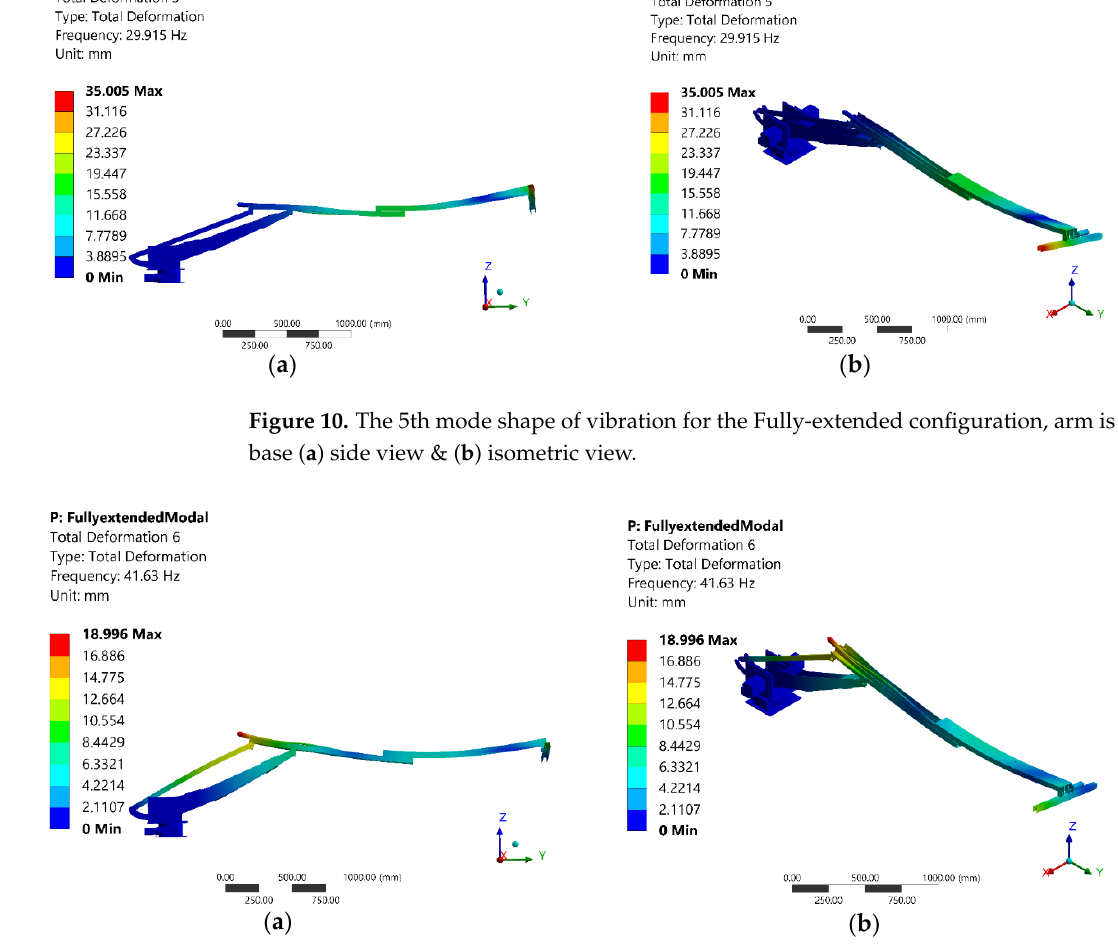
Figure 11. The 6th mode shape of vibration for the Fully-extended configuration, arm is fixed at the base ( a ) side view & ( b ) isometric view.